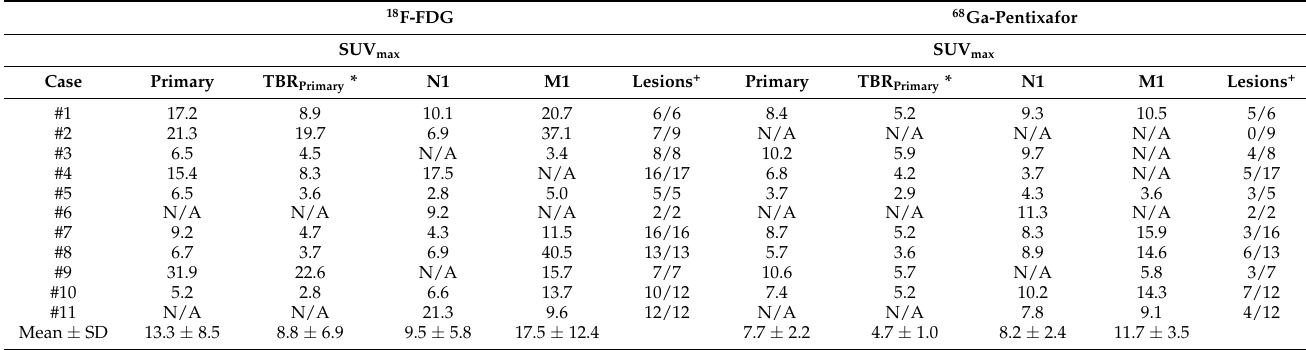
Table 2. PET results. Displayed data are the respective measurements of the maximum standardized uptake value (SUV max ). 18 F-FDG, 18 F-fluorodeoxyglucose; Lesions + , detected lesions and total lesions; M1, hottest haematogenous metastases; N/A, data not available; N1, hottest lymph node metastases; SD, standard deviation and TBR, tumor-to-background ratio of the primary tumor (* SUV max of the primary divided by SUV mean of the